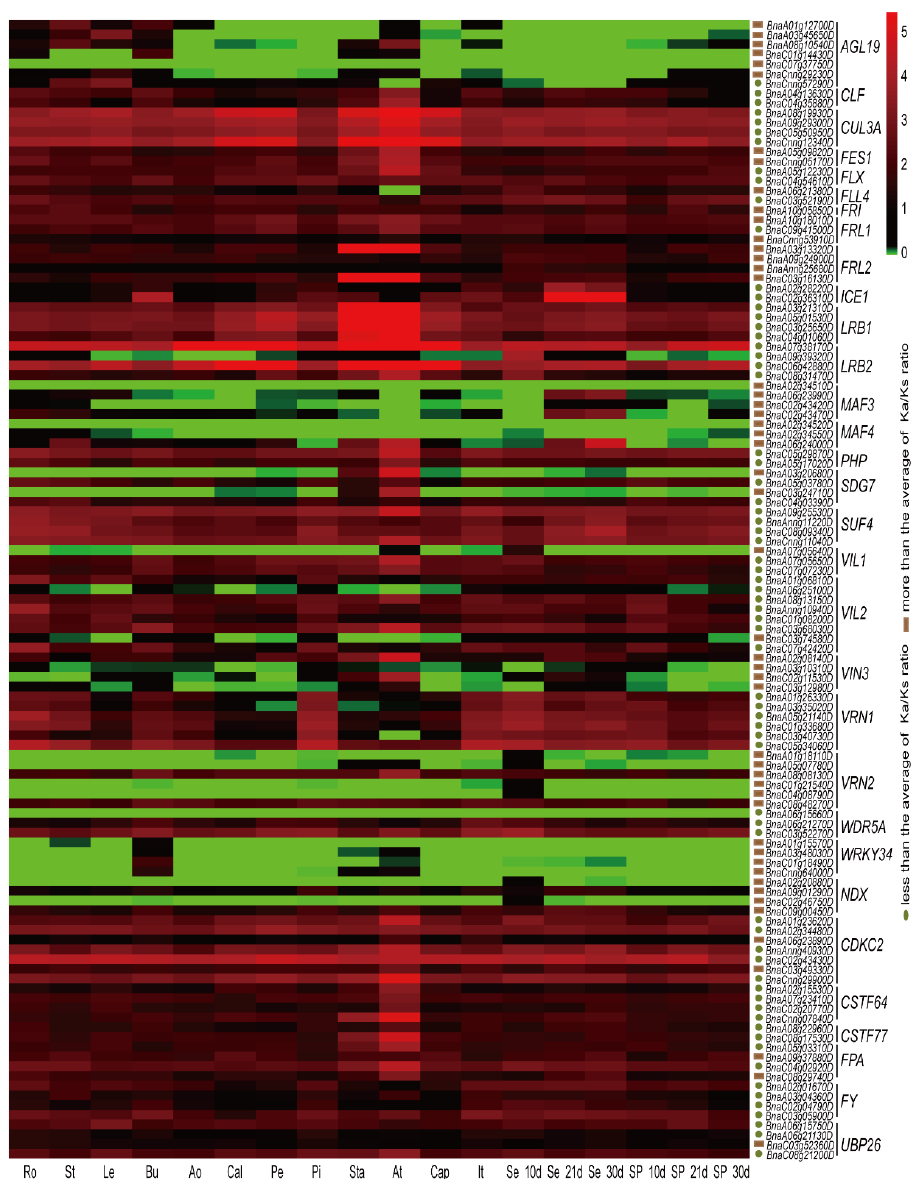
Figure 5. Organ-specific expression profiles of flowering-time genes in the vernalization pathway of B. napus . The expression patterns of these genes were obtained from RNA-seq data. The color bar at the upper right side of the figure represents Log 2 (FPKM + 1), with green representing little or no expression. The root (Ro), stem (St), leaf (Le), bud (Bu), anthocaulus (Ao), calyx (Cal), petal (Pe), pistil (Pi), stamen (Sta), anther (At), capillament (Cap), and inflorescence top (It) organs were harvested at the initial blooming stage, while seeds (Se) and silique pericarps (SP) were harvested after 10, 21, and 30 days in the field. The brown box represents high Ka/Ks gene pairs and the dark green ellipse represents low Ka/Ks gene pairs. FPKM: fragments per kilobase of exon model per million reads mapped.